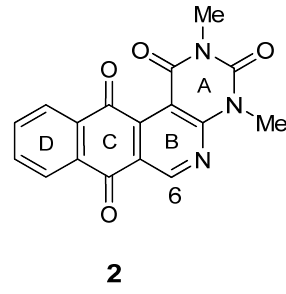
Figure 2. Structure of angular N -heterocyclic quinones with antitumor